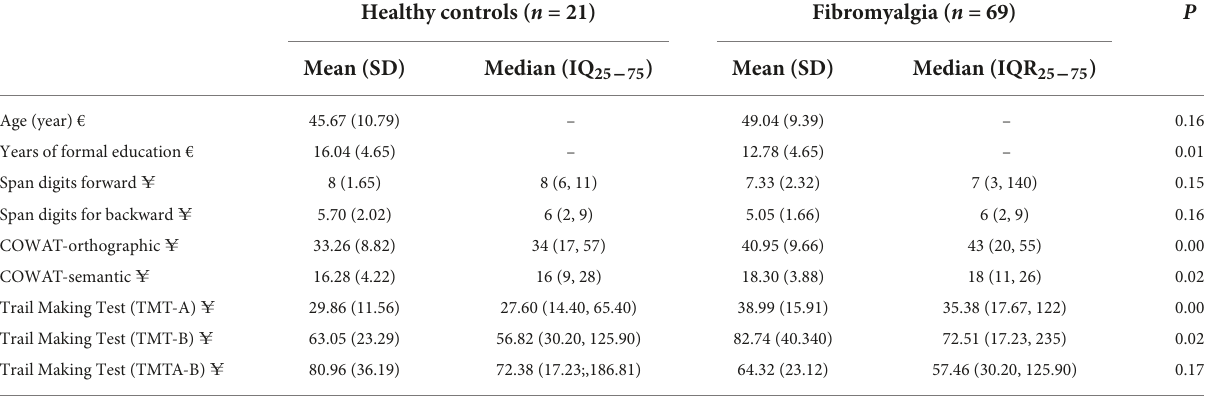
TABLE 1 Demographic characteristics and cognitive performance of FM and HC (total n =